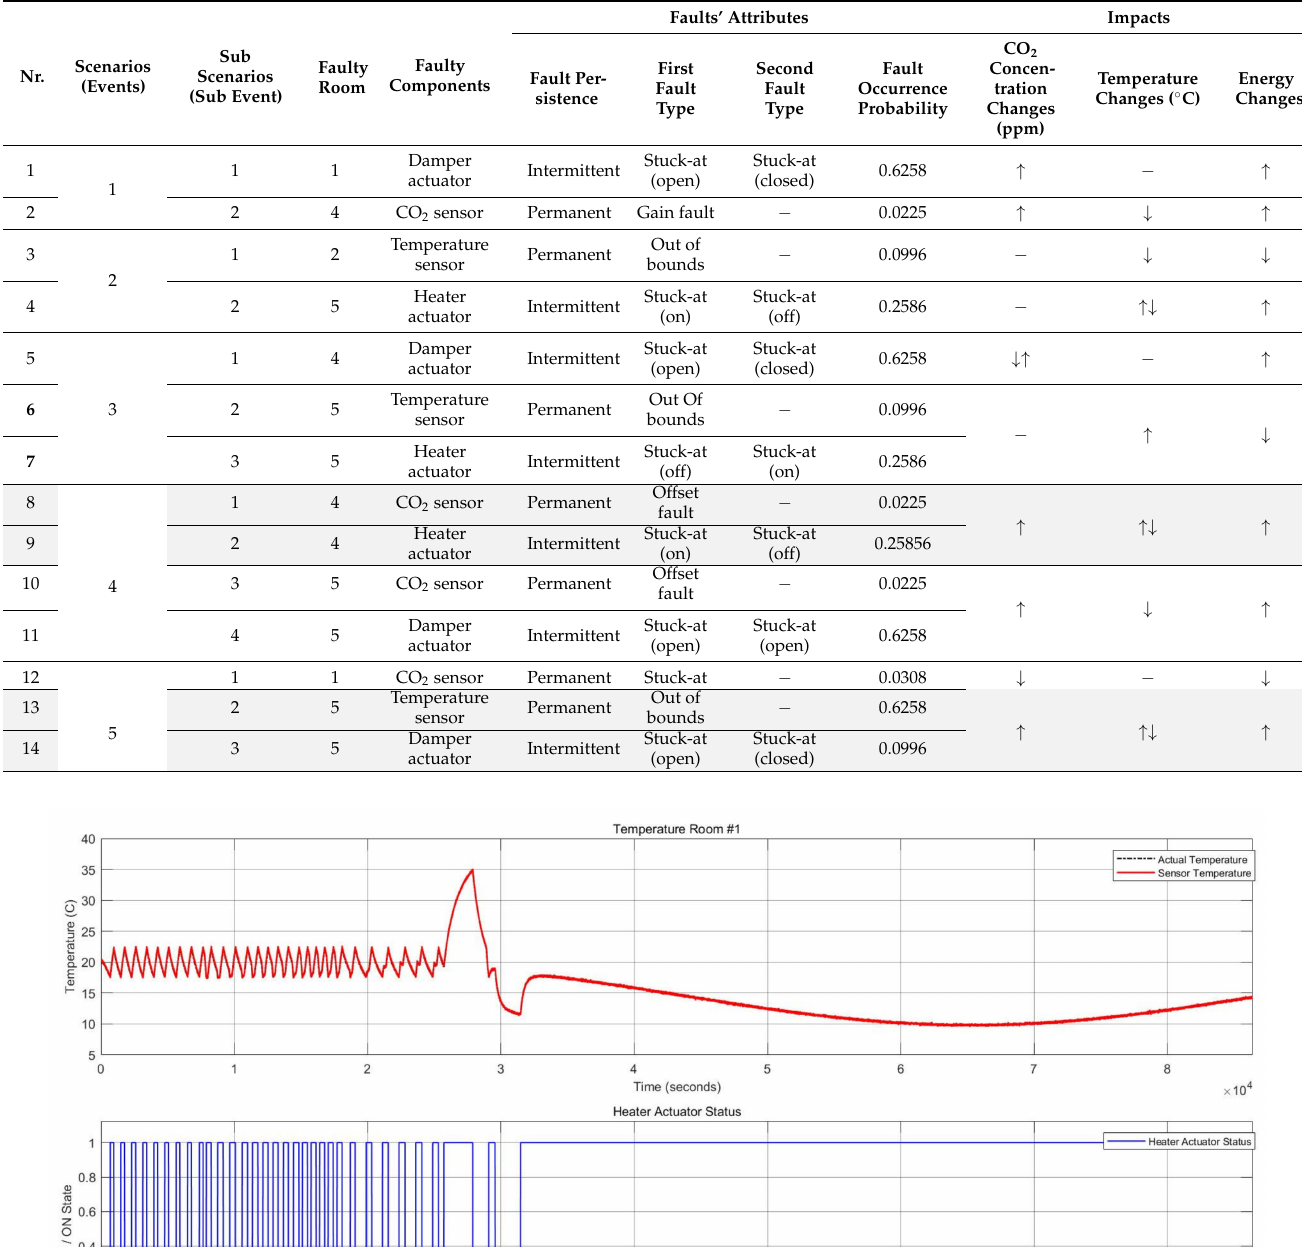
Table 6. Scenario descriptions for the FI framework in the HVAC system.